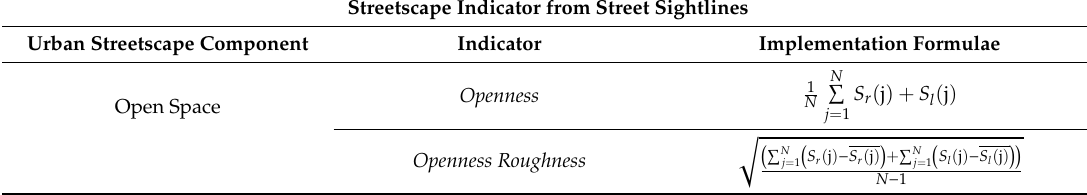
Figure A1. Graphical representation of the two skeletal streetscape GIS protocols. On the left: building façade described through sightlines perpendicular to the street centerline, homogeneously distributed (3 m). On the right: building footprint and volumes captured by the proximity band approach (source: [89]). Table A4. Summary table of the 36 directional centrality indicators. r , radius; S , squares; C , coastline; AS , anchor stores.